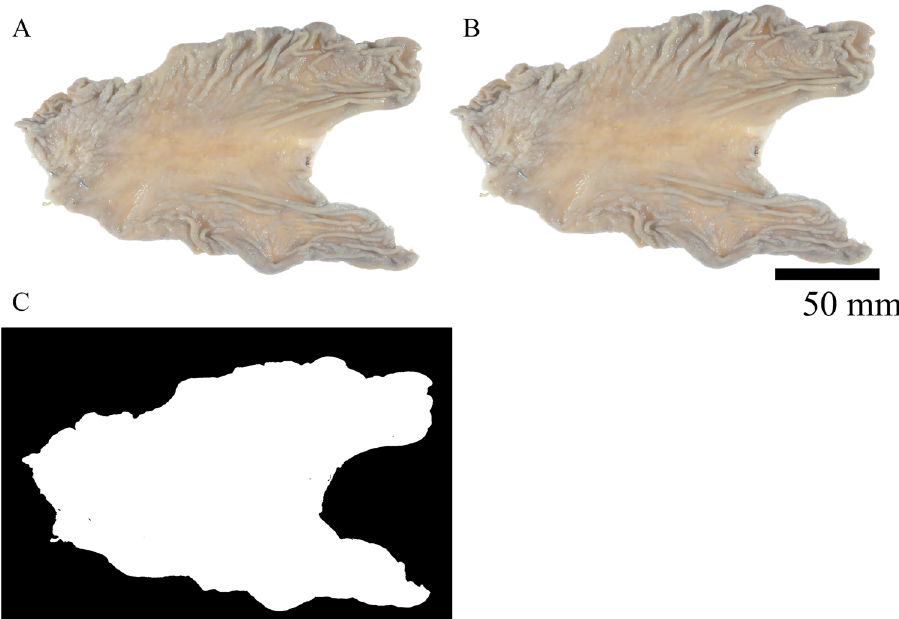
Figure 1. Resected area calculation using ImageJ: ( A ) Import the original image to ImageJ. ( B ) Set the scale bar along the ruler in the original image and define its length as 50 mm. ( C ) Process the image to make it